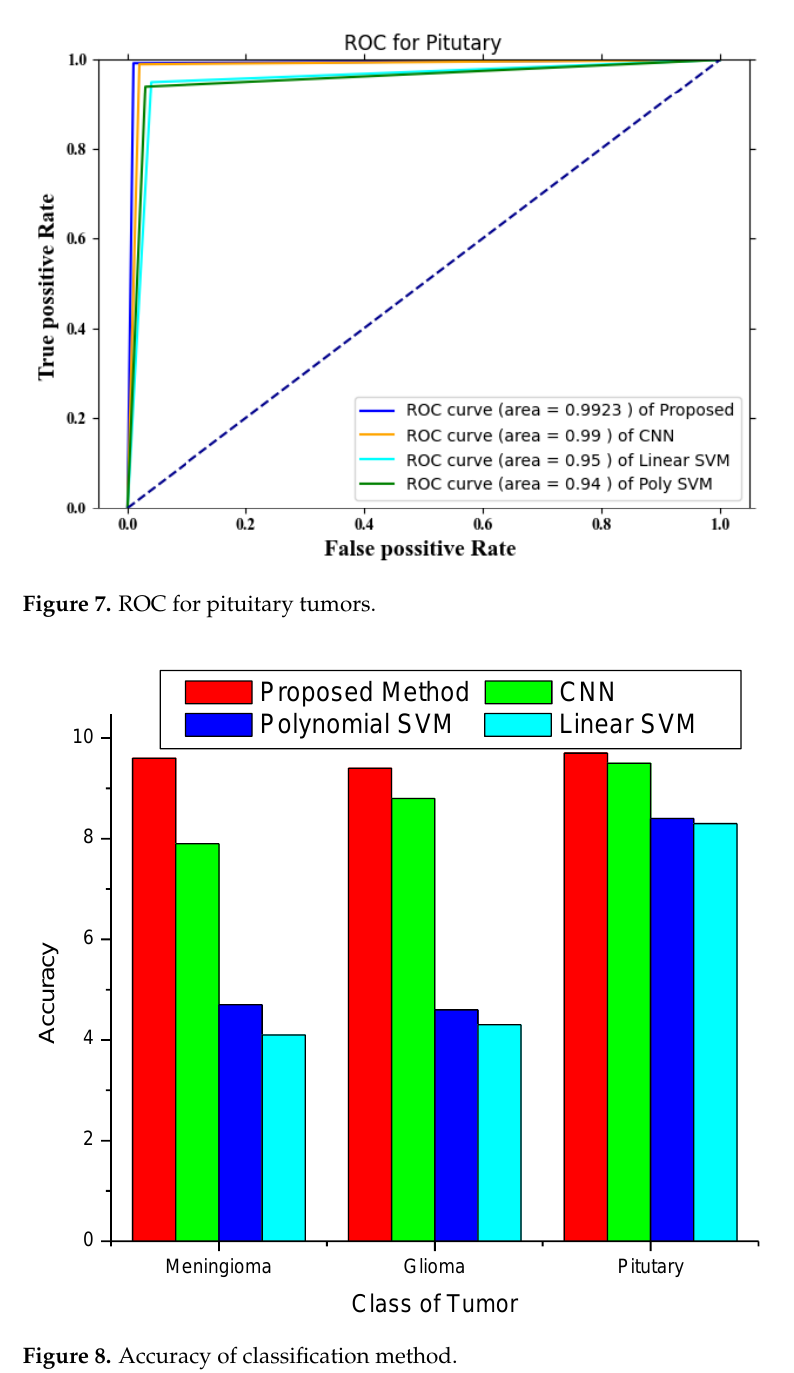
Figure 9. Precision of classification method.